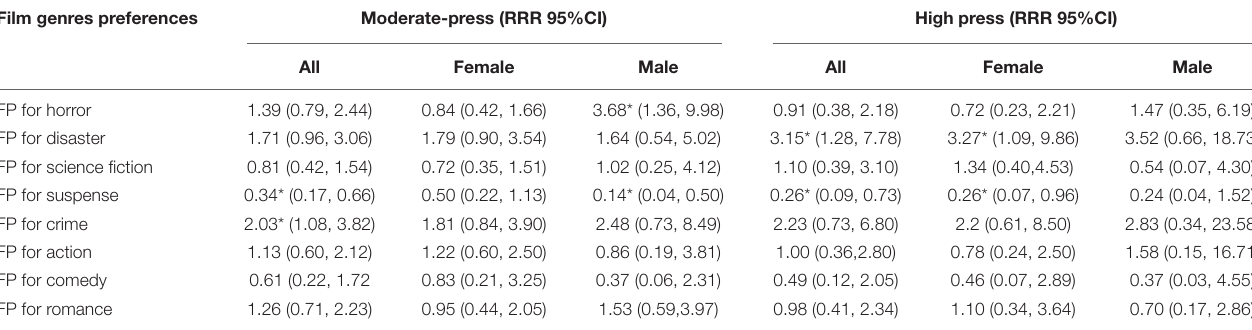
TABLE 3 | Relative risk ratios (RRR) estimated by multinomial regression on associations between pressed stress and film genres